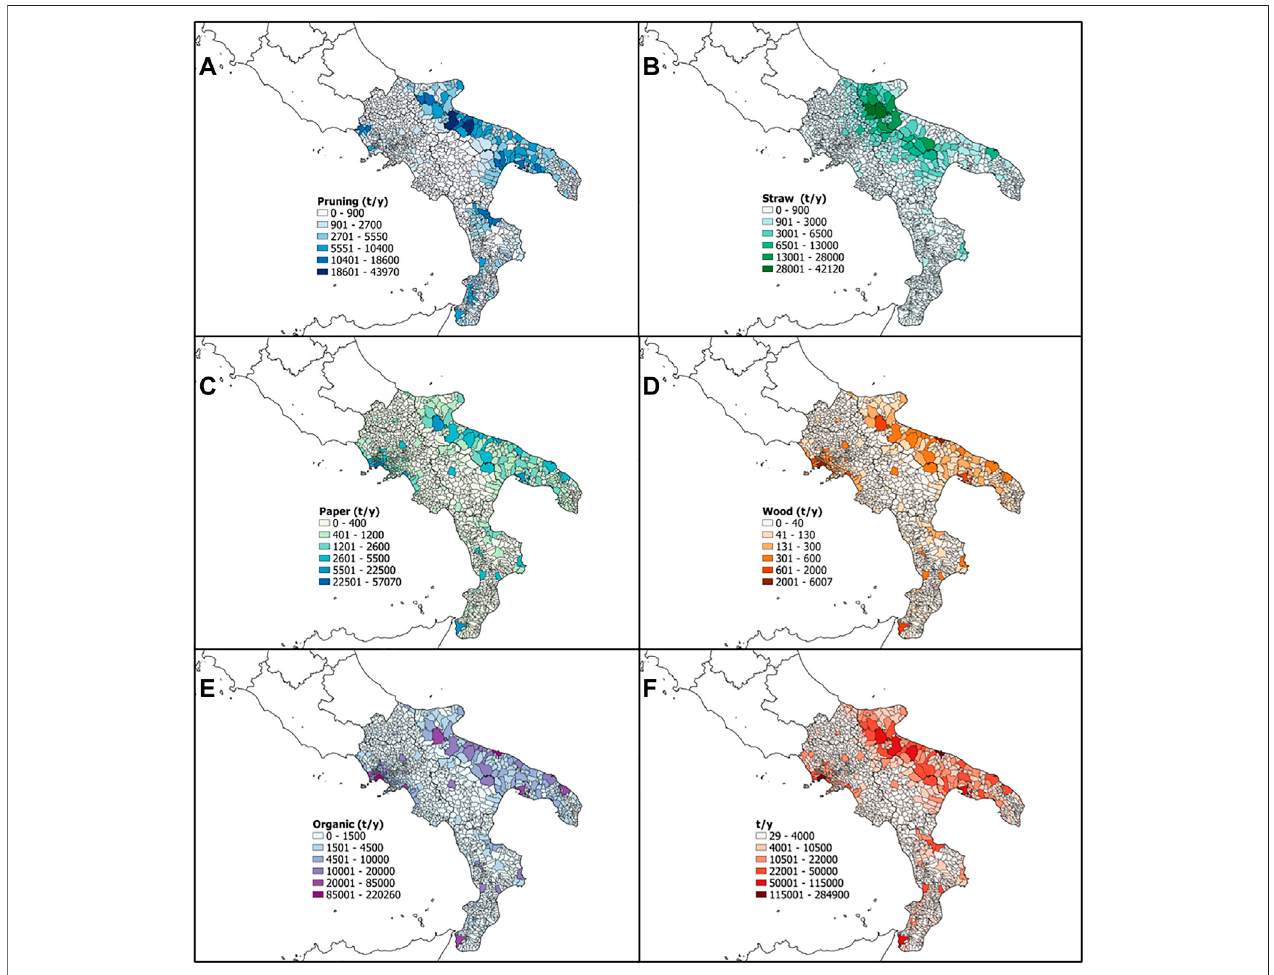
FIGURE 8 | Georeferenced maps of 2030 projections, technical potential for (A) pruning, (B) straw (C) wood, (D) paper (E) municipal organic waste, and (F) total feedstocks availability.